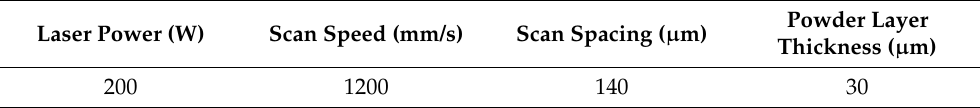
Table 4. SLM parameters.